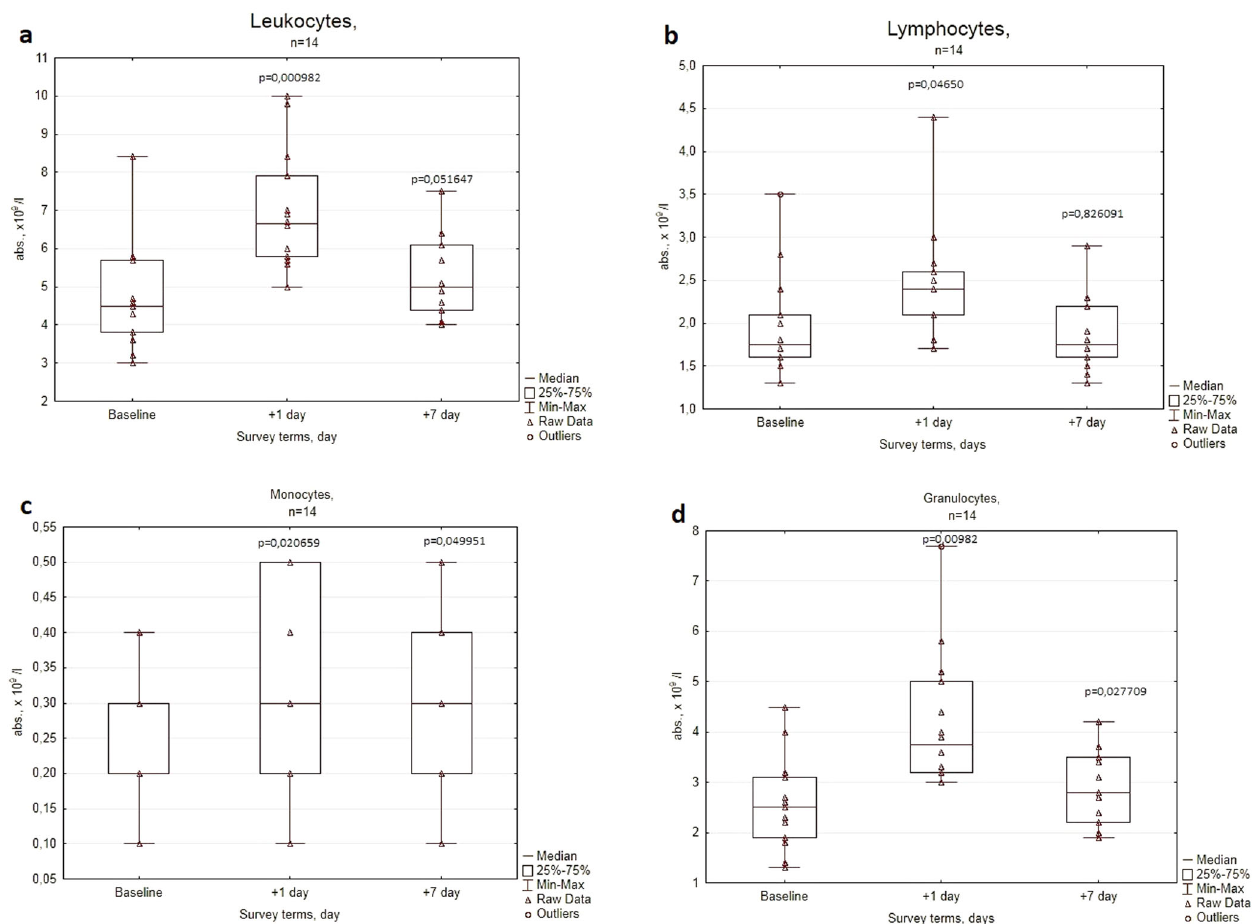
Fig. 2 Cosmonauts ’ leukograms before (Baseline) and after space missions (Days + 1 and + 7). The concentrations of the following cell populations are represented: a leukocytes, b lymphocytes, c monocytes, d granulocytes. The center lines represent the median, the bounds of boxes represent the 25th percentile and 75th percentile (Q1 and Q2 correspondingly), the bonds of whiskers represent the minimum and the maximum values, the triangles within the diagrams are the raw data for particular volunteers, p values were obtained using the Wilcoxon ’ s